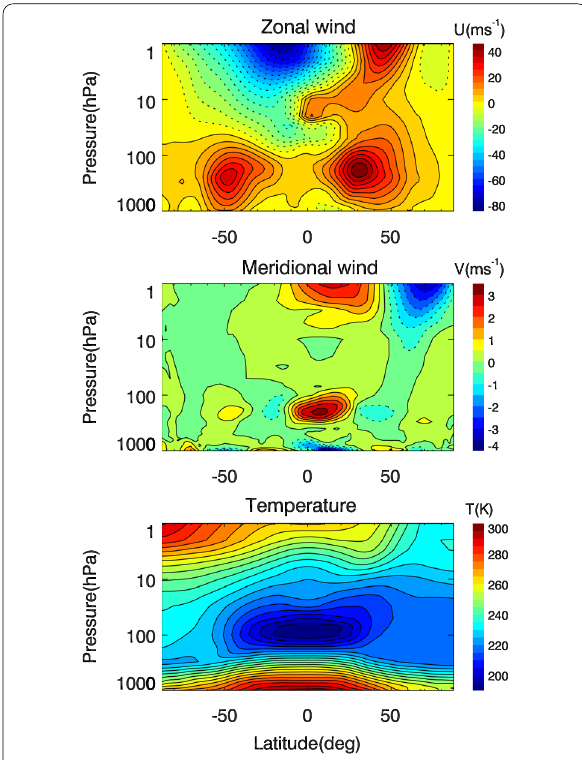
Fig. 1 Monthly averaged zonal-mean zonal wind (top), meridional wind (middle) and temperature (bottom) in January 2013 from the ERA-Interim